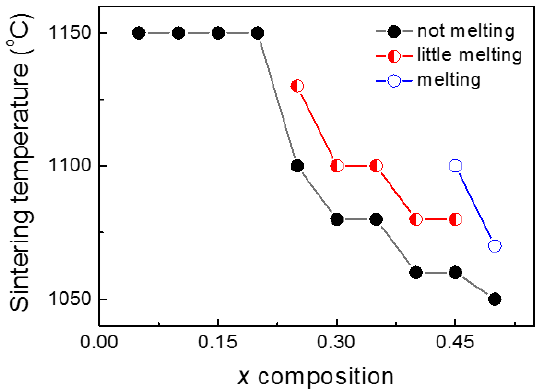
Figure 1. The variation of sintering temperature depending on x composition. We can see differences in the covered shapes in terms of their meting degree from not melting to little melting then completely melting.